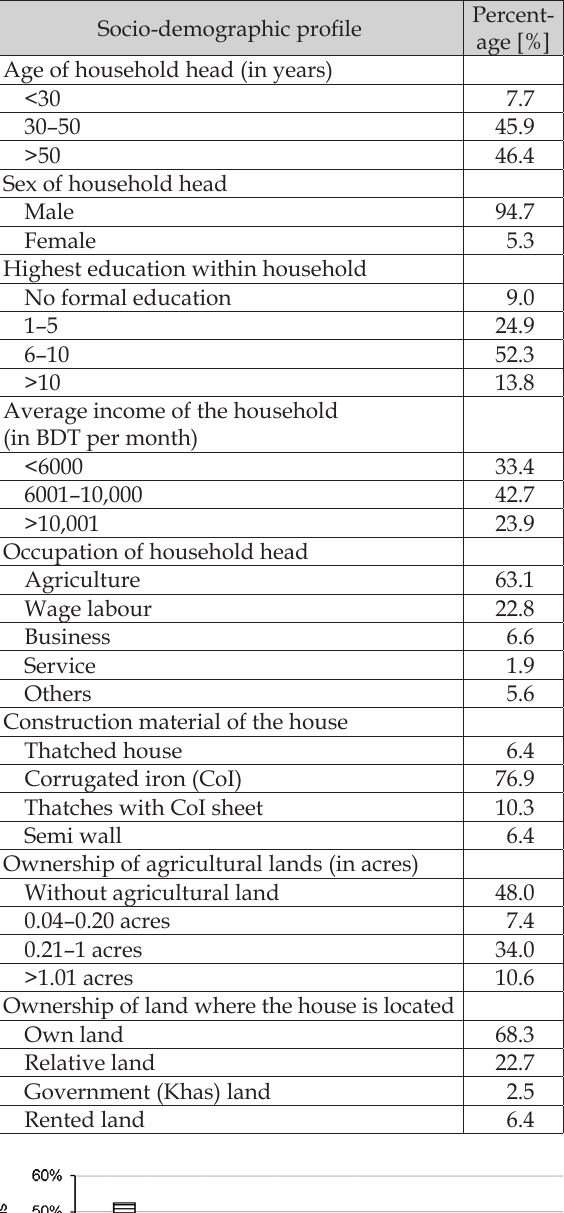
Table 4. Selected socioeconomic and demographic characteristics of the surveyed households, n = 377,